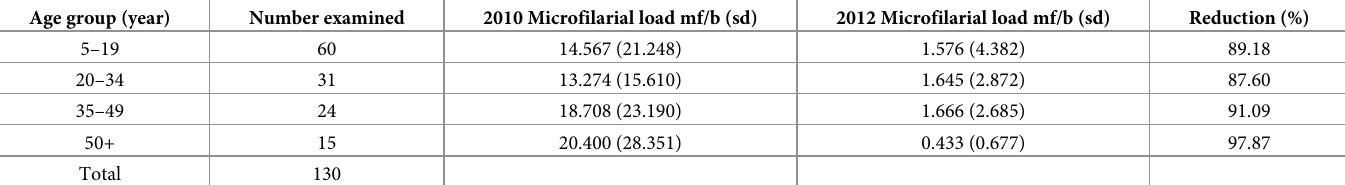
Table 2. Microfilarial Load of Participants in 2010 and 2012 by Age